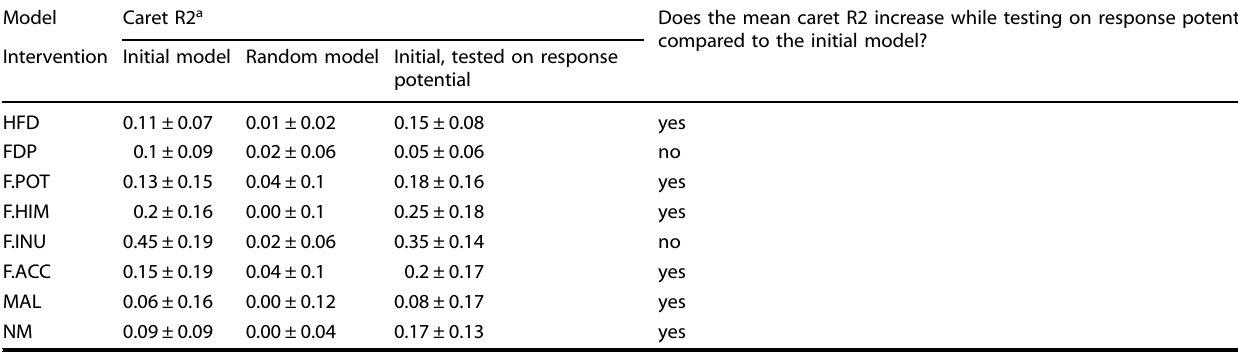
Table 1. Average model quality characteristics obtained in 50 iterations of cross-validation trained and tested on initial data, on the data with randomly permuted sample names, and after substitution of response values with the response potential values in the testing sets. Model Caret R2 a Intervention Initial model Random model Initial, tested on response